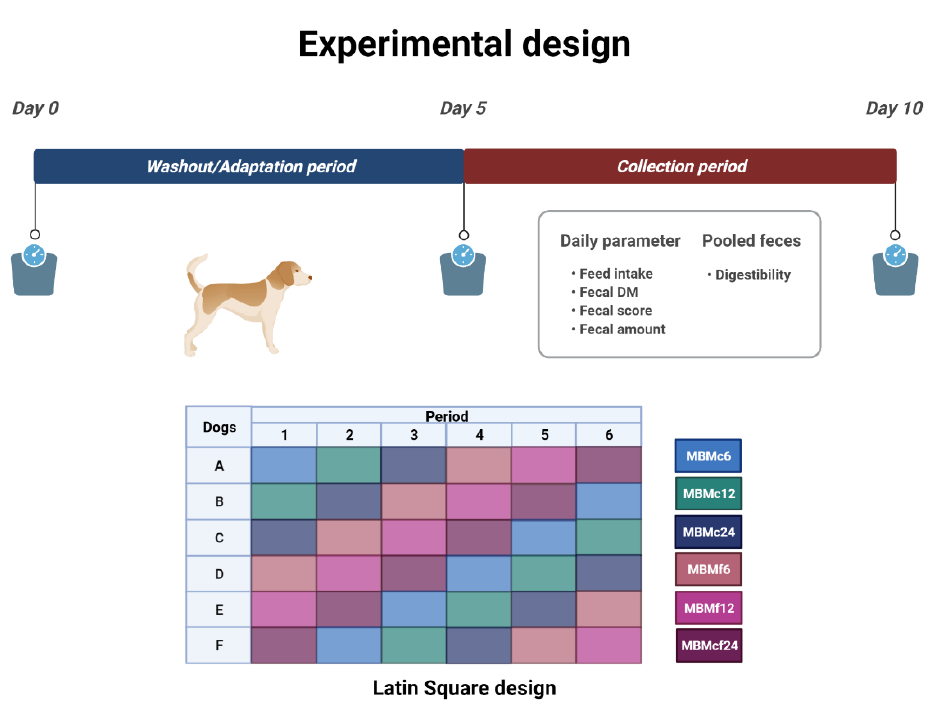
Figure 1. Concept of the Latin Square experimental design and parameters recorded during the collecting period (Figure was created with BioRender.com (accessed on 24 March 2022)).